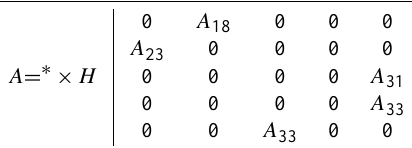
Table 16. The matrix of options optical Table13. Matrix of alternative ranking